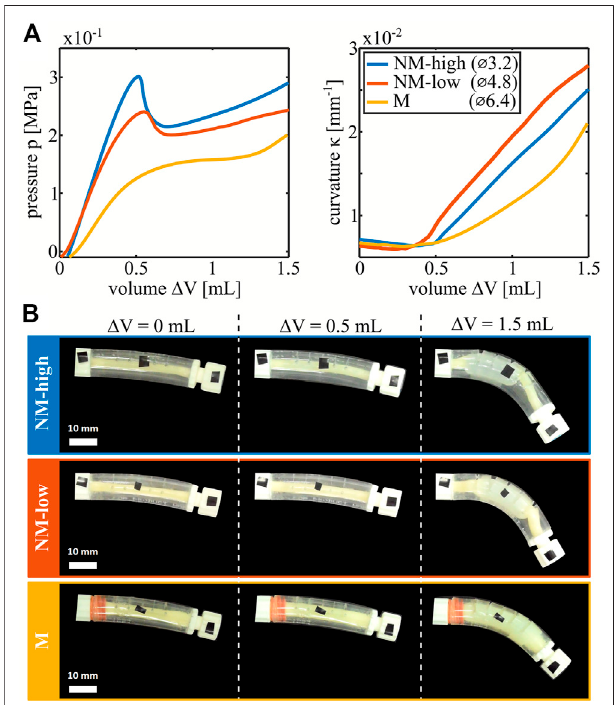
FIGURE 2 | Characterization of the three types of manufactured nonlinear bending actuators differentiated by the outer diameter of the latex balloon. (A) PV curves and curvature-volume curves of the actuators. (B) Deformedcon fi gurationforeachtype ofactuators at0,0.5and1.5 mlof volume